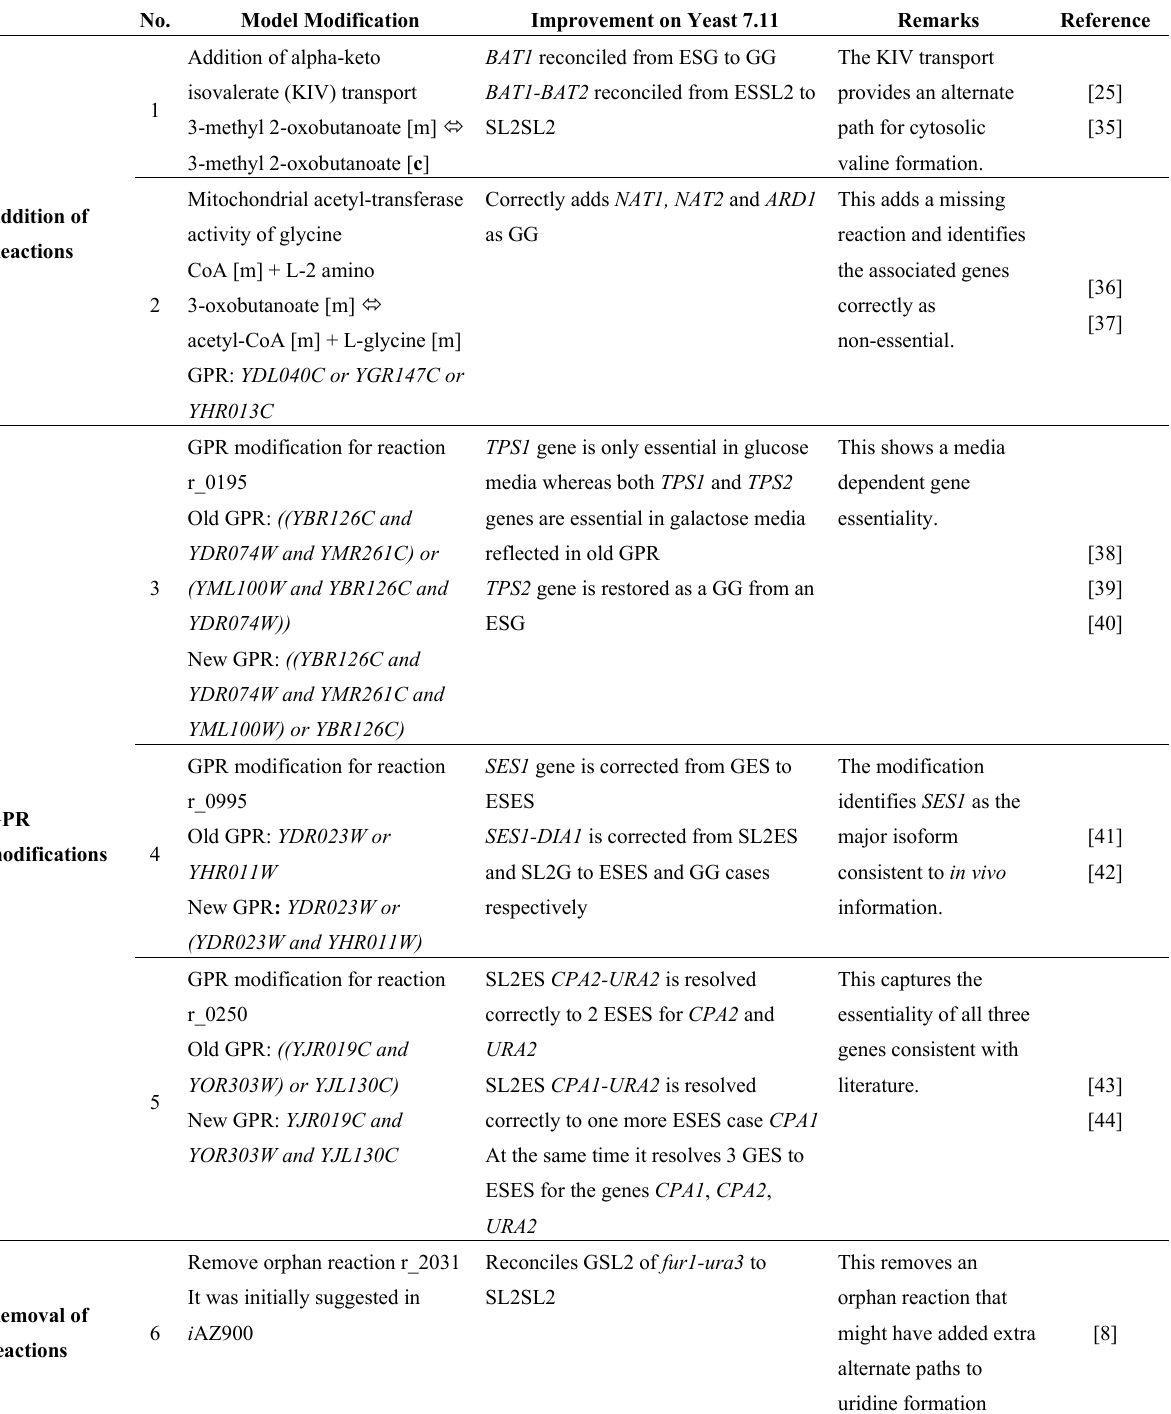
Table 2. Yeast 7.11 Model